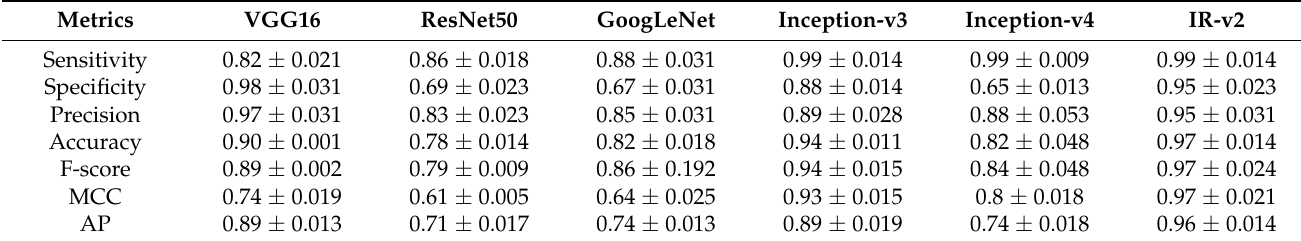
Table 2. Customized models with performance metrics along with SD.